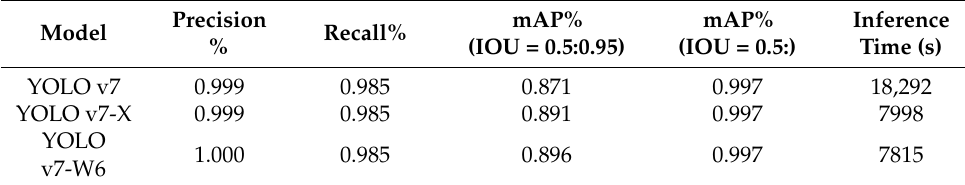
Table 5. The detection results with the different YOLO v7 models.